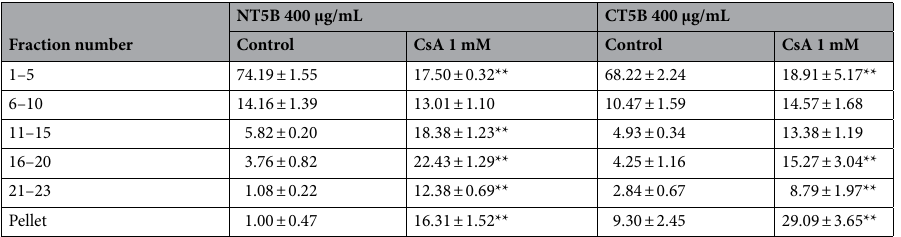
Table 3. Percentage of NT5B and CT5B in sucrose gradient fractions. Results are presented as the mean ± s.e.m. (n = 3–6) from 3 independent experiments. * P < 0.05, **p < 0.01 compared with control condition (ANOVA followed by Dunnett’s method). The percentage of NT5B and CT5B in fractions across the sucrose gradient was calculated from Fig. 4.